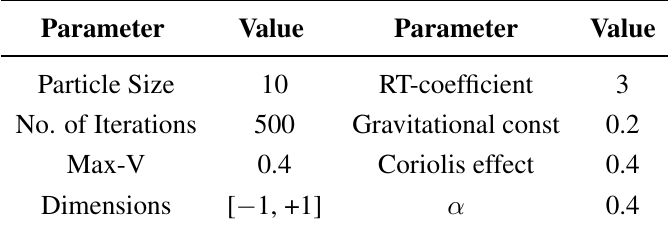
Figure 4. Convergence comparison of the PSO algorithm using the sphere and step functions. Table 4. Control parameters for the WDO algorithm.